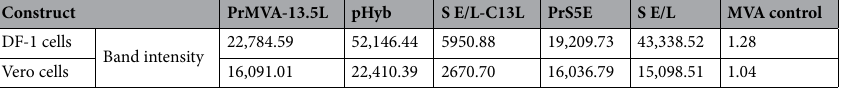
Table 1. Band intensities of p30 protein counted in western blot images. Scanned membranes from immunoblots of DF-1 and Vero cells were processed using the ImageJ software. Bands from each construct were selected and quantified to obtain histograms. The acquired data was normalized using ß-actin to obtain the relative quantification of the p30 protein.